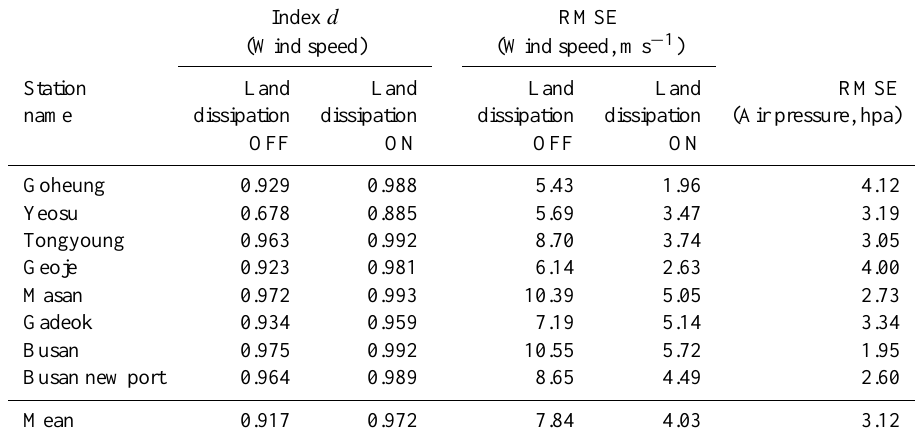
Table 3. A comparison of index d and RMSE on the influence of the land roughness effect for each station (see Figs. 4 and 9, and Table 1 for